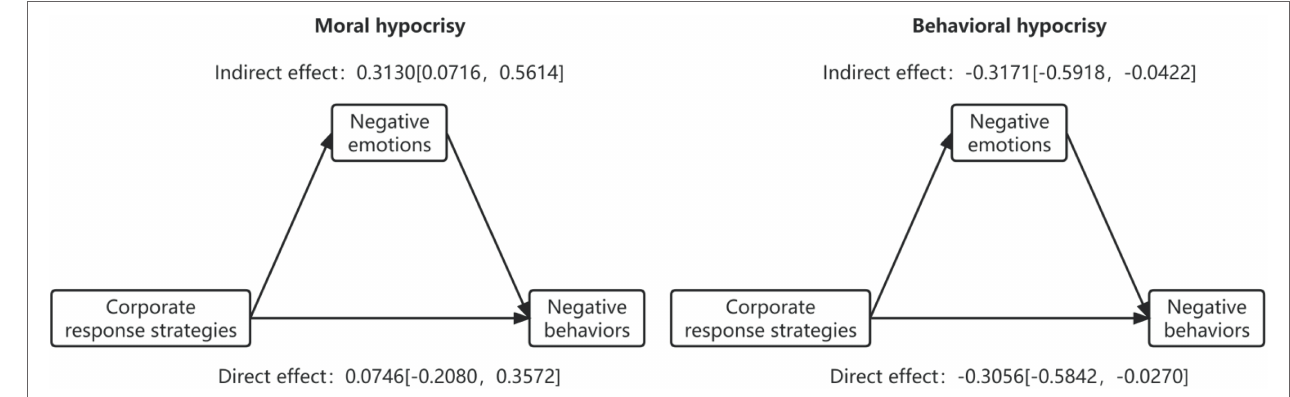
FIGURE 6 | Description of mediating